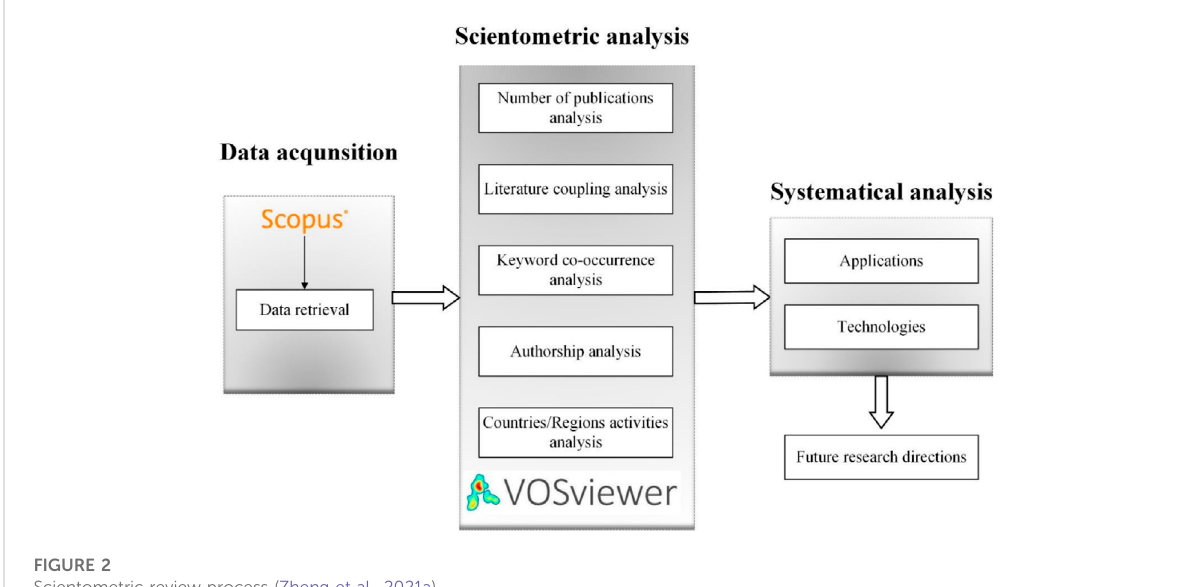
Scientometric review process (Zheng et al., 2021a).